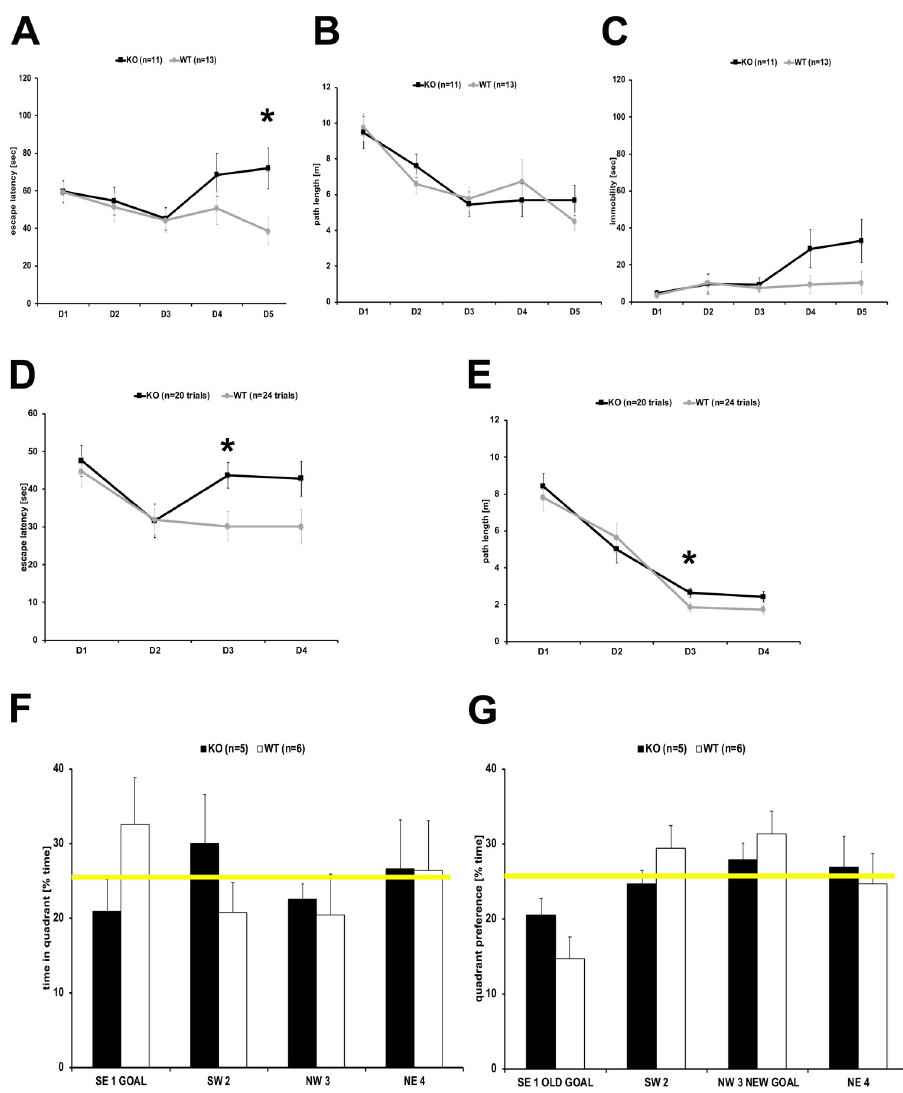
Fig 2. Spatial learning of BT-IgSF-deficient mice in the water maze. In the water maze protocols 1 (A-C) and 2 (D-G) with short acquisition phase, BT-IgSF-deficient (black line) showed similar escape latencies (A, D) and pathlengths (B, E) during acquisition but needed much longer time after the platform was moved to a different position compared to littermate controls (grey line). This was mainly caused by longer times of immobility (C). Whereas control mice (white columns) established a goal quadrant preference (F) quickly, BT-IgSF-deficient mice (black columns) did not establish a significant preference for the goal quadrants (F, G). Yellow line indicates chance level 25% in F (probe trial 1) and G (probe trial